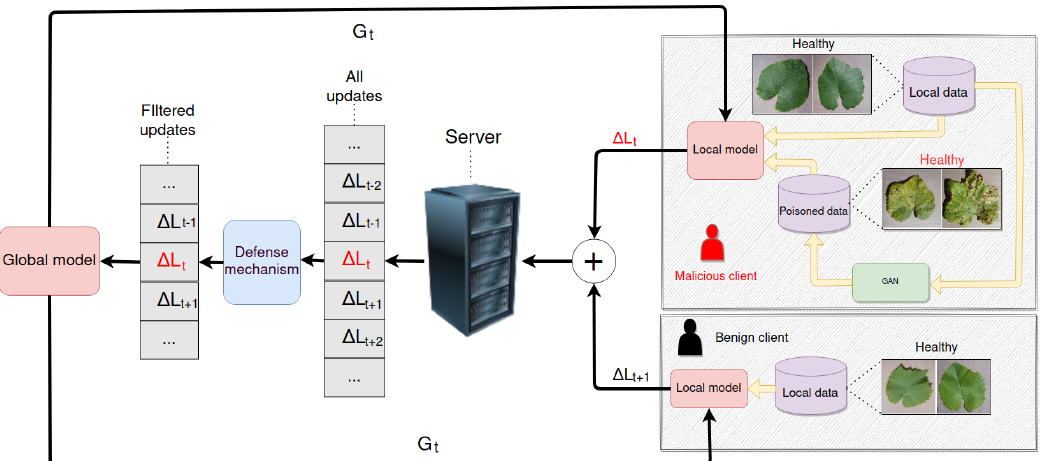
Figure 1. Proposed process for the GAN data poisoning attack. This figure illustrates the internal structure of both benign and malicious clients involved in the GAN data poisoning attack, presenting the proposed process for carrying out the attack. Additionally, it examines the federated learning process while utilizing secure aggregation